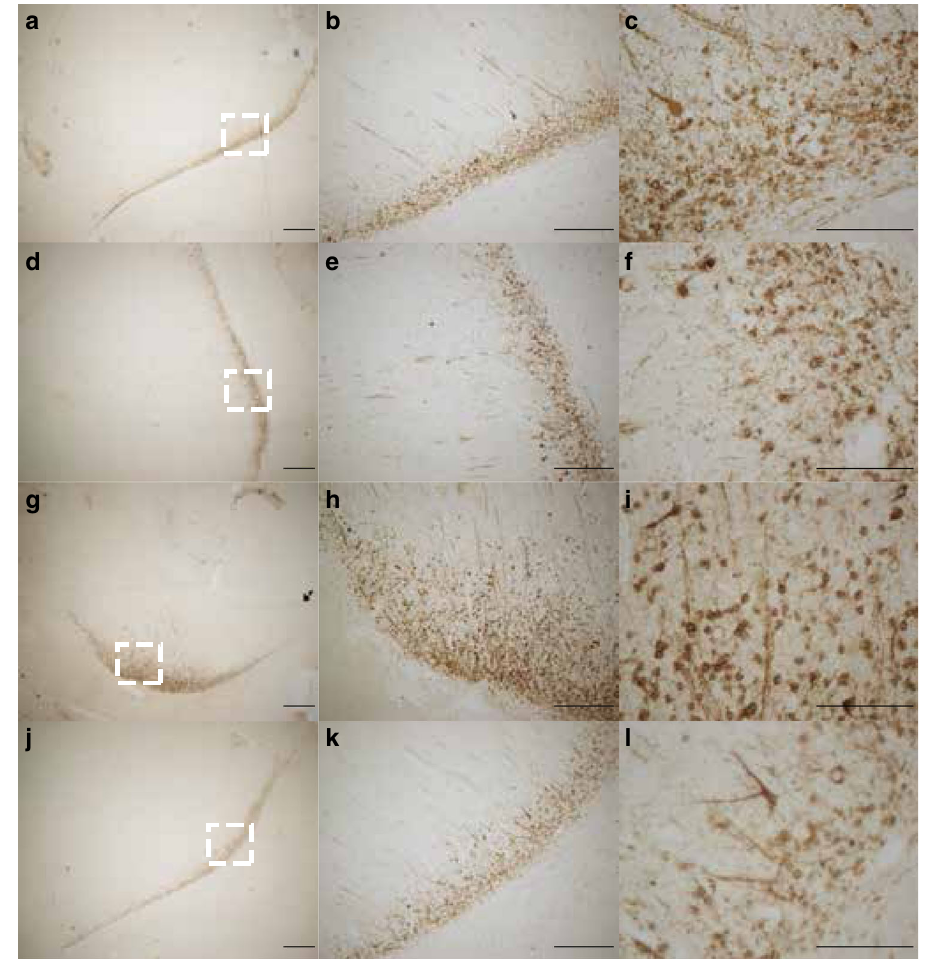
Fig. 6 Postnatal ZIKV infection decreased dendritic arborization in immature amygdala neurons. Doublecortin staining in the paralaminar nucleus of the amygdala representative sections shown for ZIKV-5 ( a – c ), ZIKV-6 ( d – f ), Control-1 ( g – i ), and Control-2 ( j – l ). Left panels ( a , d , g , j ) are taken at ×2.5 magni fi cation and the white dotted box is the location of the higher magni fi cation images. Middle panels ( b , e , h , k ) are taken at ×10 magni fi cation. Right panels ( c , f , i , l ) are taken at ×40 magni fi cation. Scale bars 2.5× = 500 µ m; 10× = 250 µ m; 40× = 100 µ